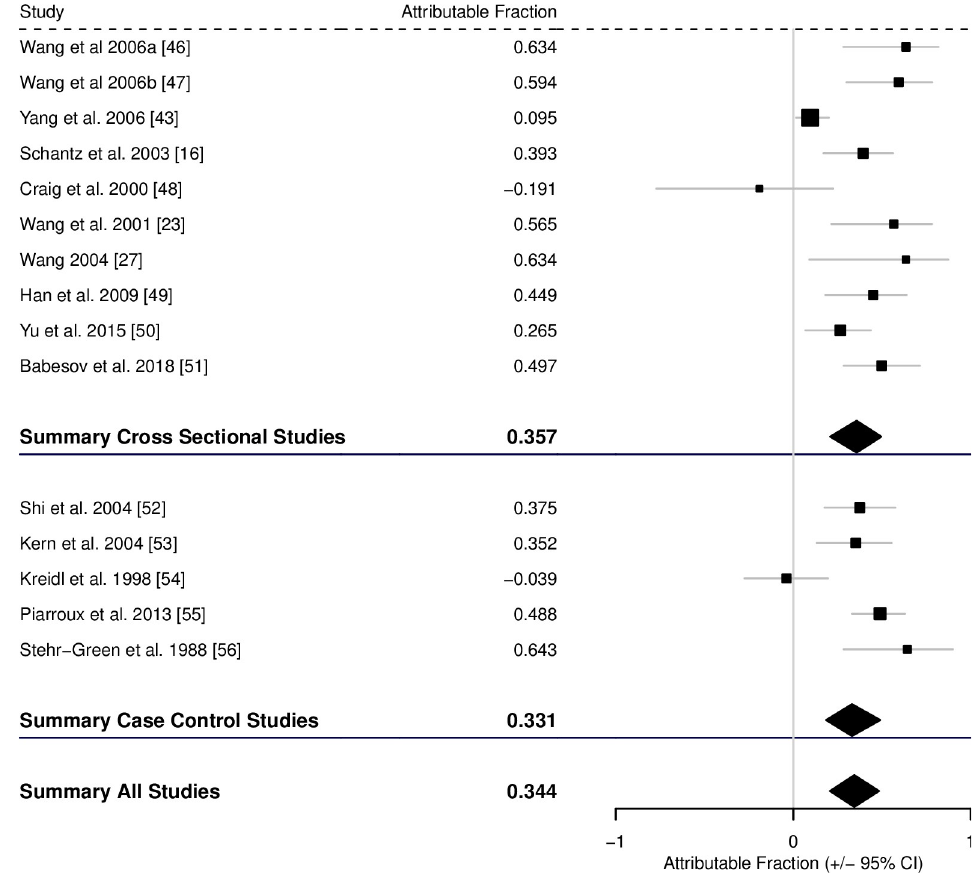
Fig 7. Forest plot for the attributable fraction for 10 cross-sectional studies and 5 case-control studies that analysed contact with infected dogs as a potential risk factor for human AE.